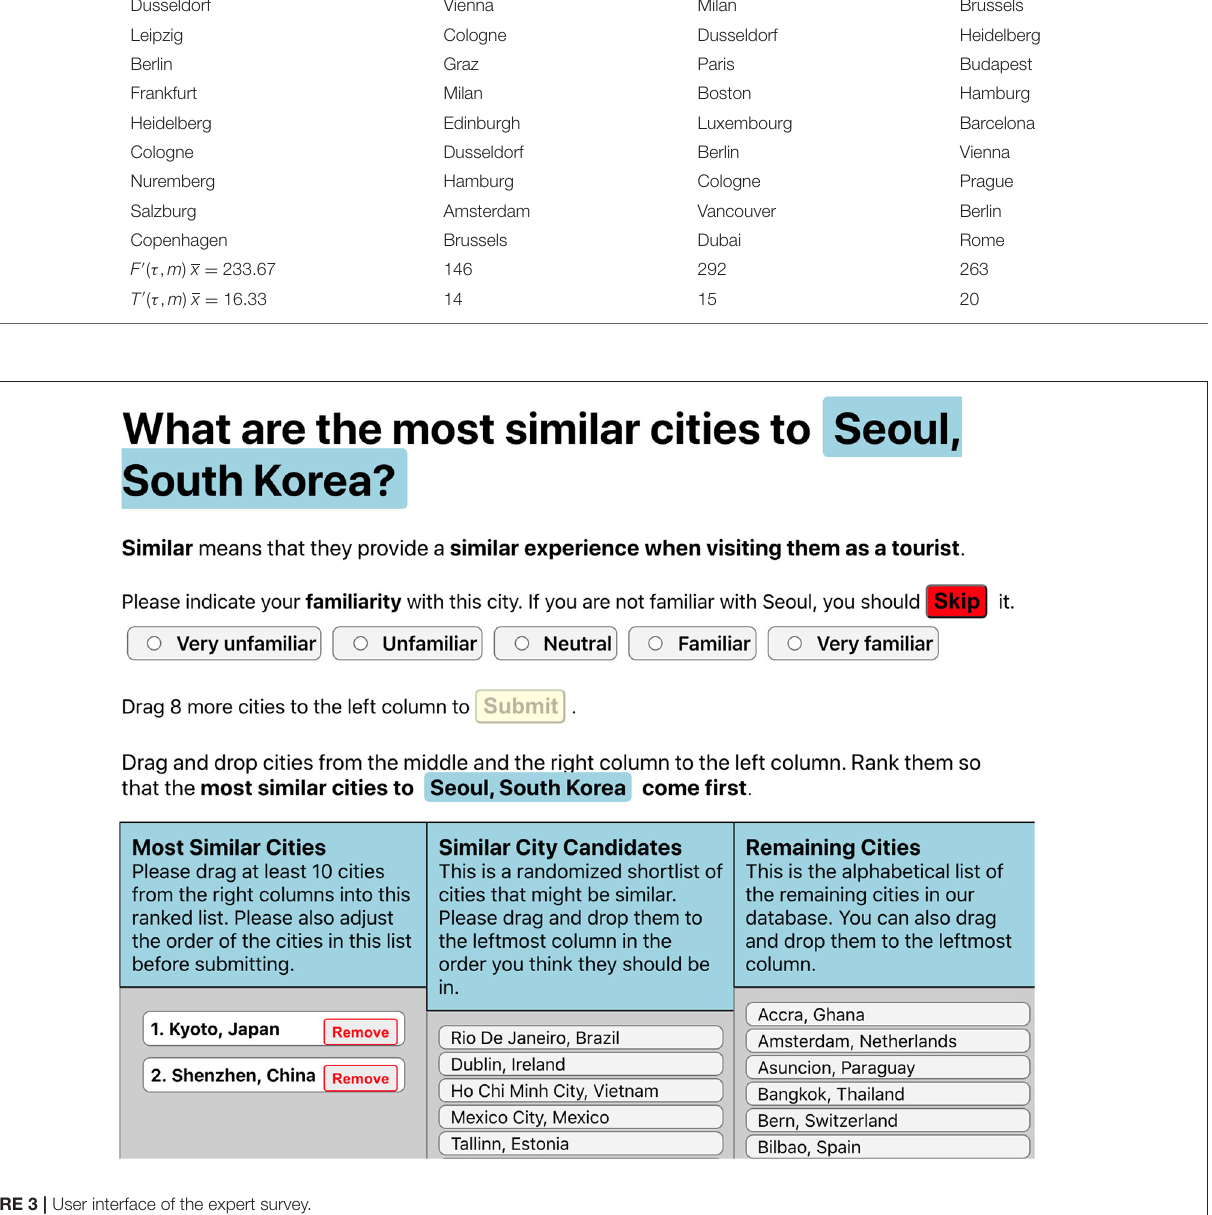
FIGURE 3 | User interface of the expert